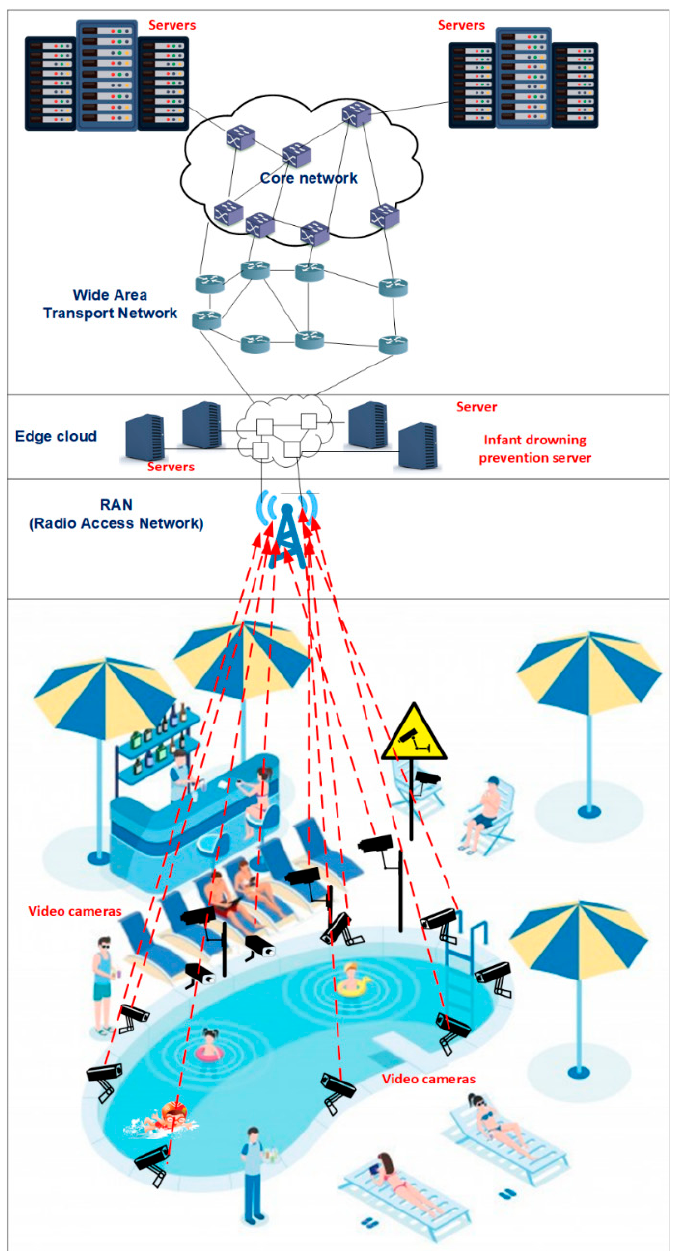
Figure 1. Proposed 5G-enabled child drowning prevention system.